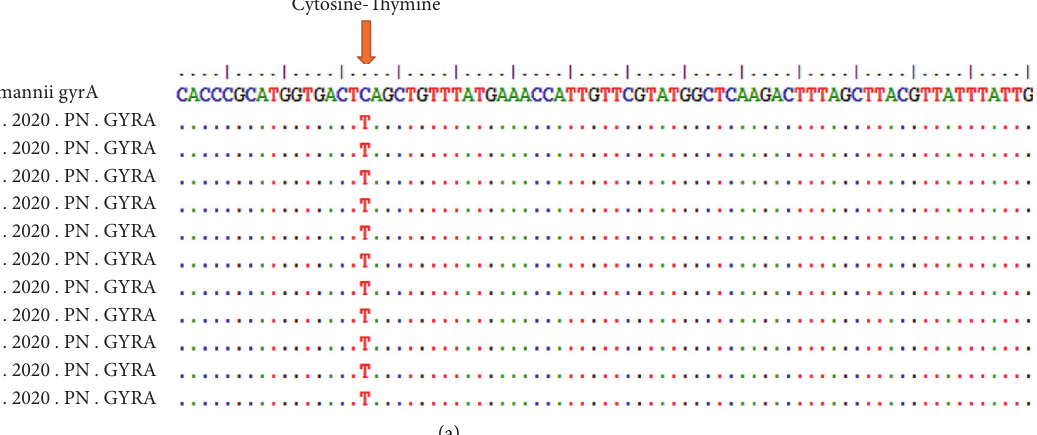
Cytosine-Thymine